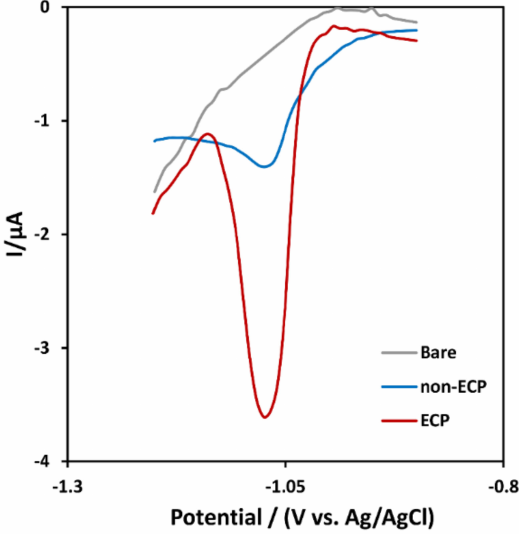
Figure 6. DPV of Bare, non-ECP, and ECP of a modified electrode for 500 µ g/L of alprazolam in Britton–Robinson buffer solution (BRB) with a pH of